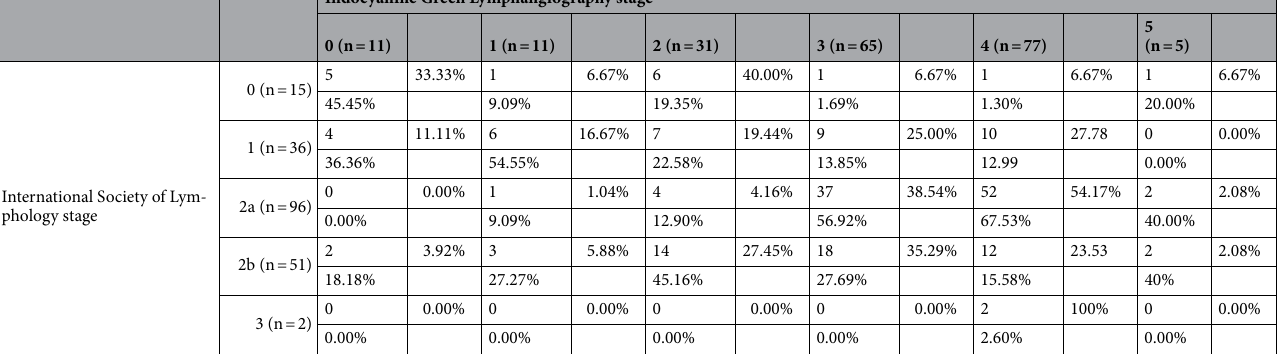
Table 4. Indocyanine green lymphangiography and clinical lymphedema staging contingency. This table shows the contingency between the Indocyanine Green Lymphangiography stage and the International Society of Lymphology stage. N = number of patients at each